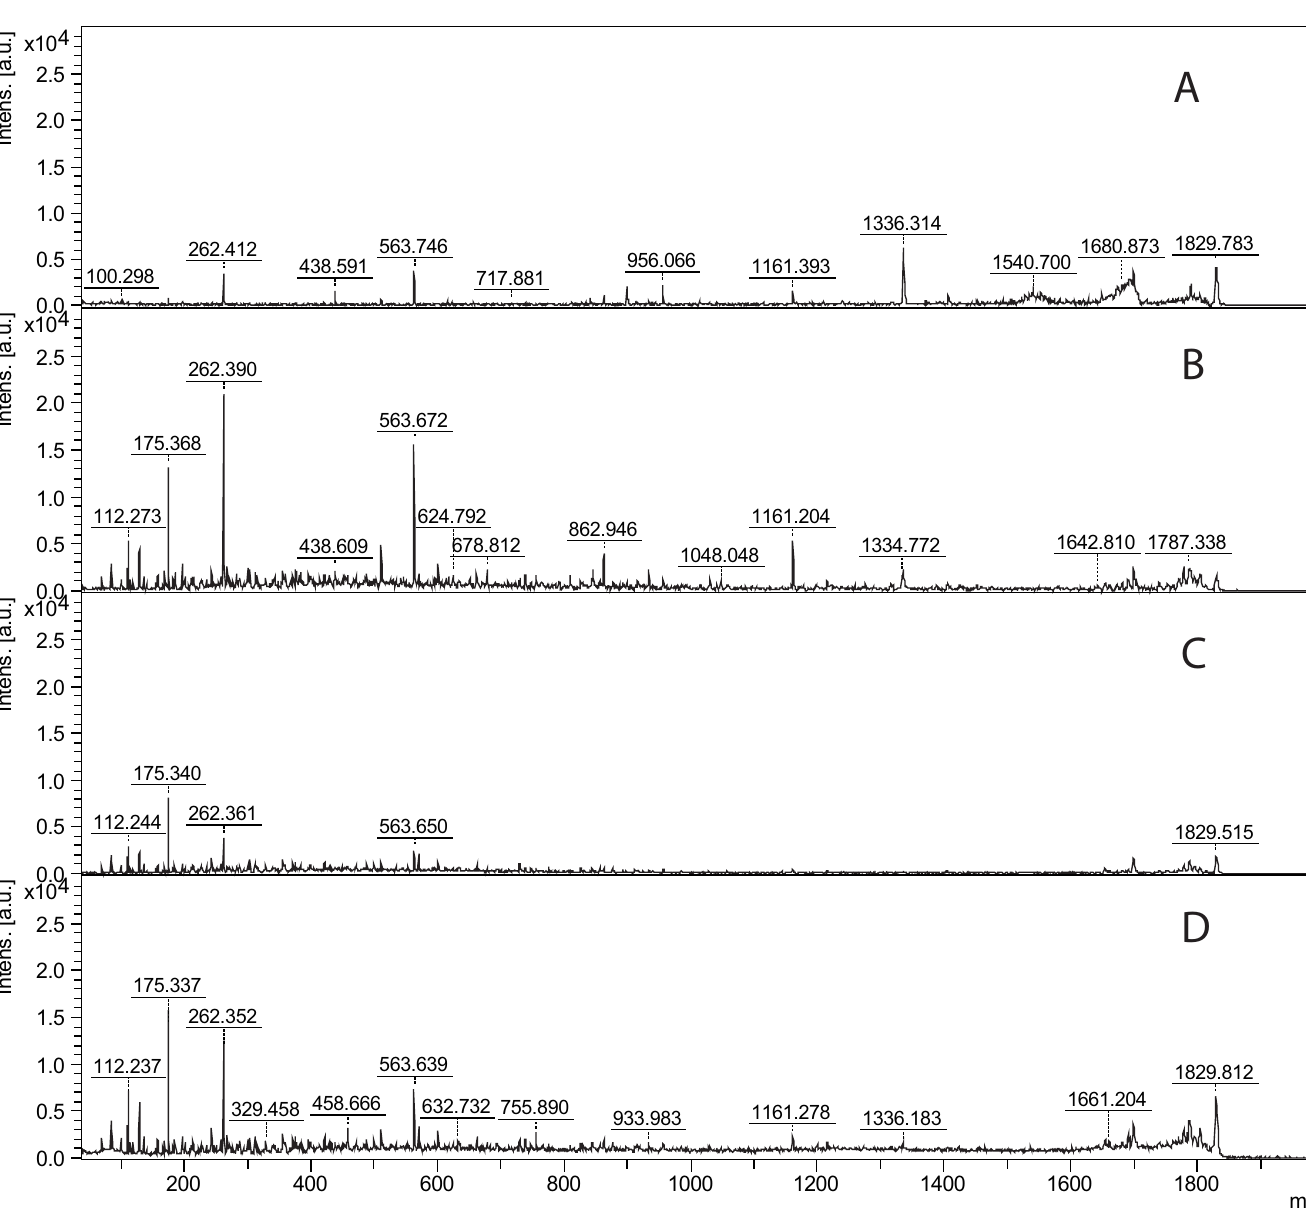
Fig 7. MALDI-TOF MS/MS on the peak at m/z 1854.898, trypsin digests of Elution fraction 3. (A) 2 μ g/ml rhOPN in human plasma, DHB, (B) 2 μ g/ml rhOPN in human plasma, saturated HCCA, (C) 1 μ g/ml rhOPN in human plasma, 2.8 mg/mL HCCA, and (D) 1 μ g/ml rhOPN in human plasma, saturated